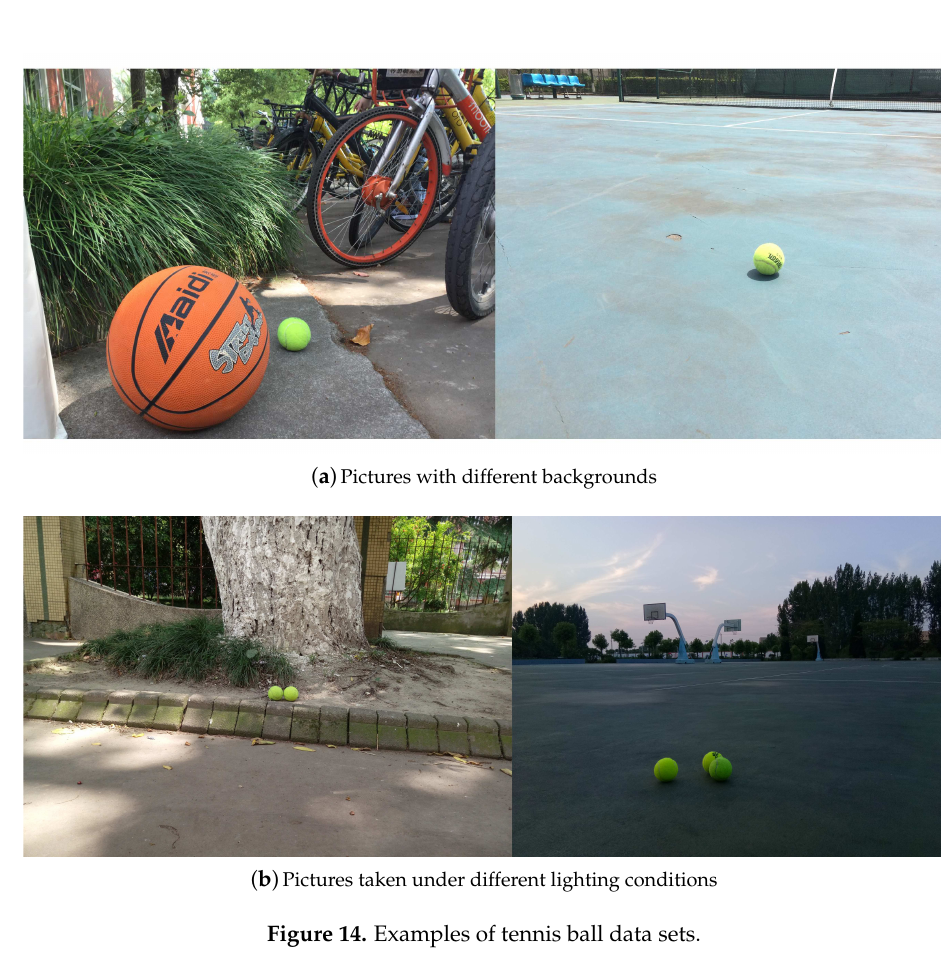
Figure 14. Examples of tennis ball data